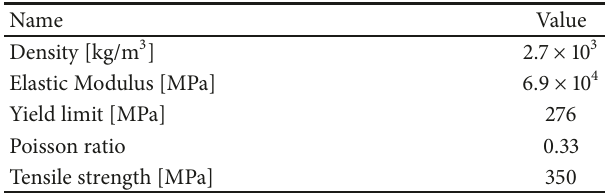
Table 4: Material properties of drag